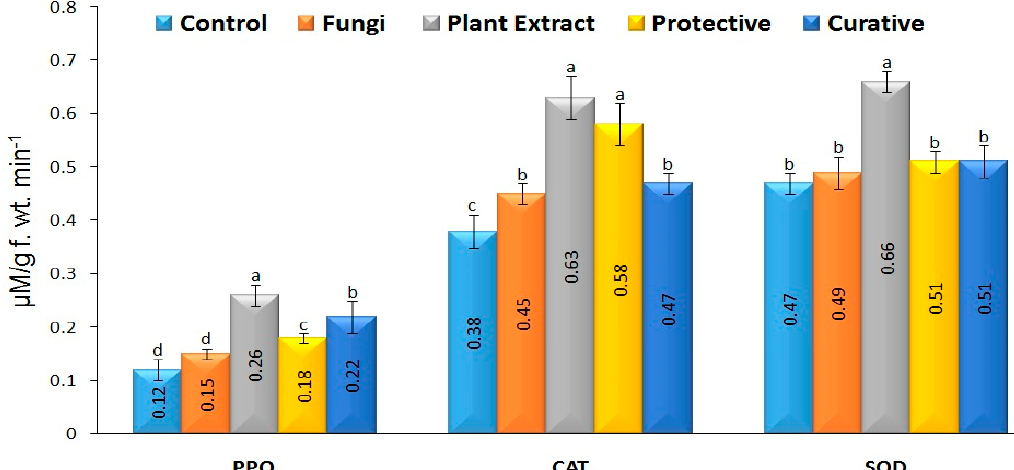
Figure 7. PPO, CAT, and SOD enzyme activities under the studied different treatments. The post hoc test analysis of each antioxidant enzyme was conducted separately. The different letters on top of the columns of each antioxidant enzyme mean the data values were significantly different at p ≤ 0.05.